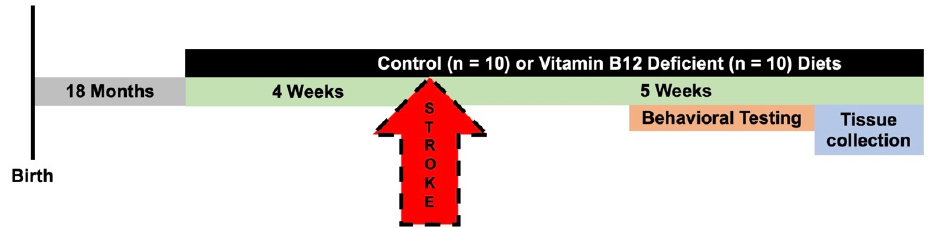
Figure 1. Timeline of experimental manipulation. Female C57Bl/6J mice arrived from Jackson Laboratories at 10 months old, and after one week of acclimation, the animals were placed on a control ( n = 10) or vitamin B12-deficient ( n = 10) diet for four weeks. Following the four weeks, ischemic stroke was induced using the photothrombosis model in the sensorimotor cortex. After stroke, the animals were maintained on their respective diets for four additional weeks. The motor function of the mice was measured using the accelerating rotarod and forepaw placement tasks. At the completion of the in vivo experiments, the animals were euthanized, and brain and liver tissue, as well as plasma, was collected for further analysis.